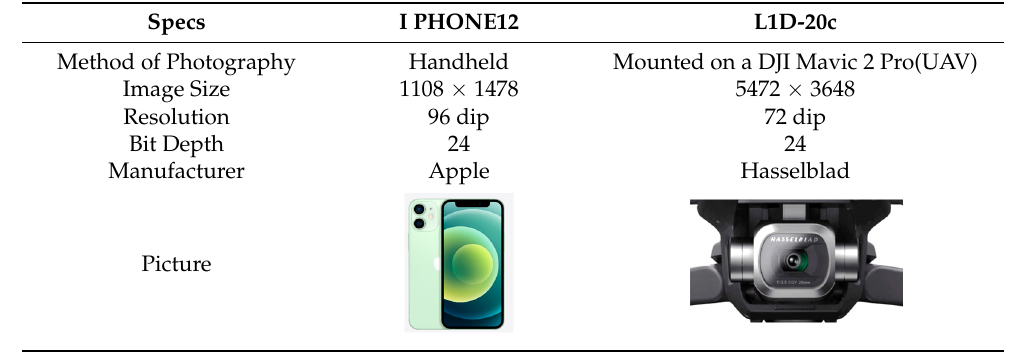
Table 1. Photography equipment [41,42].